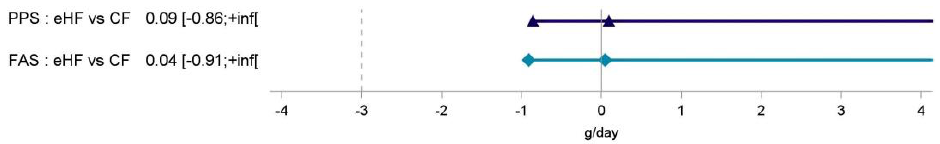
Figure 2. Difference in mean weight gain (g/day) with one-sided 97.5% interval between infant formula feeding groups from 30 days of age (V1) to 120 days of age (V4). CF: control formula; eHF: infant formula manufactured from extensively hydrolysed whey protein; FAS: full analysis set; inf: infinity; PPS: per protocol set; V: visit.